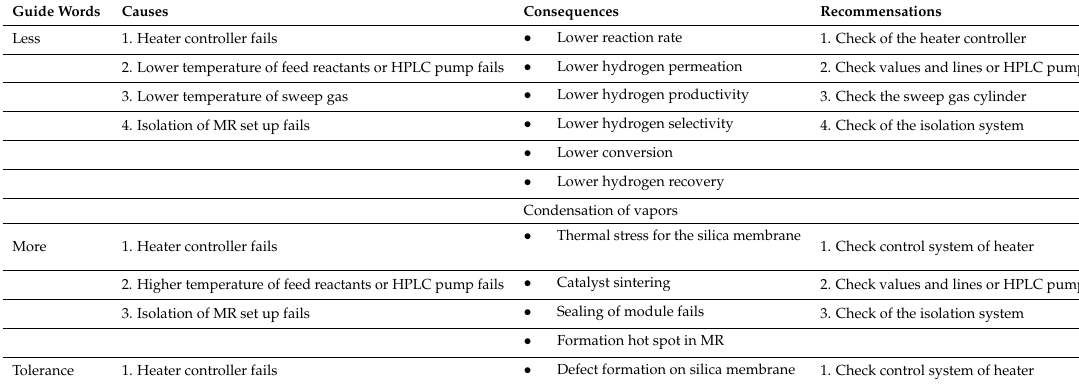
Table 1. Safety assessment of MSR reaction performed in a silica-based MR via HAZOP analysis: input-output table for deviations of the reaction temperature in the MR. With permission of reprint of Elsevier from Ghasezmadeh et al.